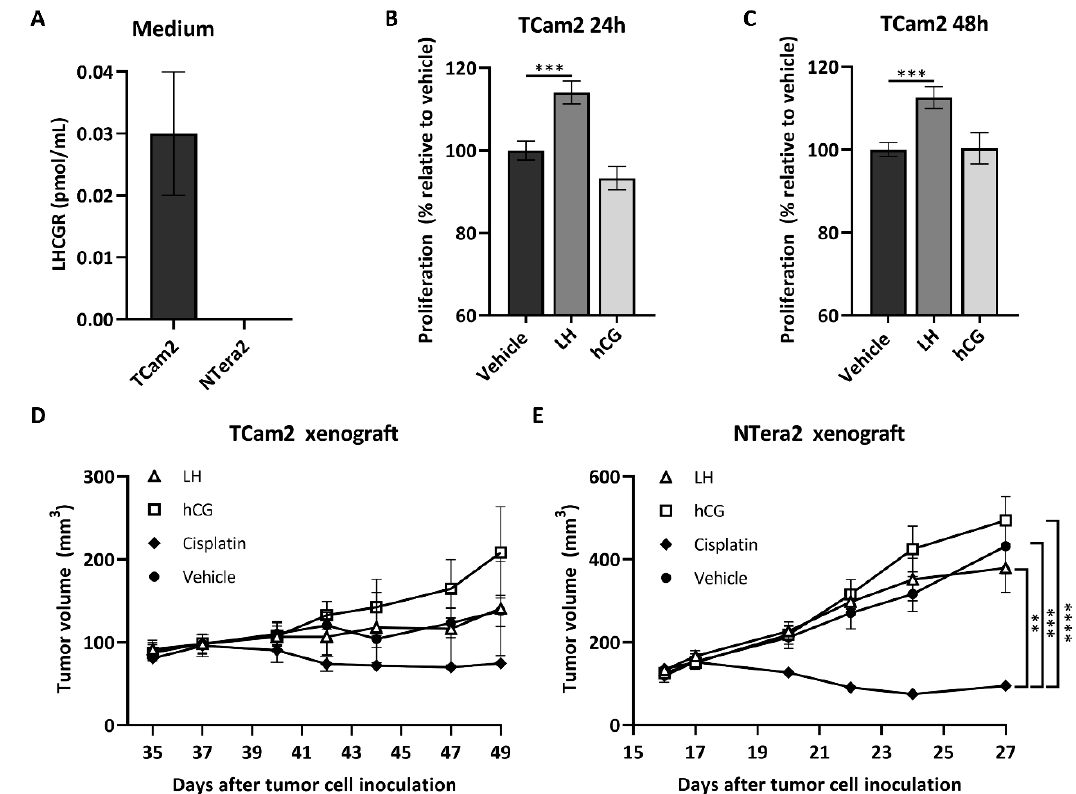
Figure 2. Stimulation of LHCGR increases proliferation of a seminoma-derived cell line. ( A ) LHCGR in cell culture medium from TCam2 and NTera2 cells measured by ELISA. TCam2 and NTera2 cells were grown until 85% confluency, the medium was changed, and the cells were cultured for 2–4 h before medium was harvested for analysis. Values represent mean ± SEM. The experiment was conducted in duplicates. ( B , C ) Cell proliferation of the seminoma-derived cell line TCam2 was analyzed by BrdU incorporation assay after 24 and 48 h of treatment with 1 IU/mL LH or hCG. Values represent mean ± SEM. All experiments are conducted in biological triplicates. *** p < 0.001 compared with vehicle treatment. ( D , E ) NTera2 or TCam2 cells were inoculated onto the flank of nude mice. At an average tumor volume of approximately 150 mm 3 , mice were randomized into different treatment groups and injected i.p. with LH (3 IU/kg 2 times/week), hCG (1000 IU/kg 3 times/week), cisplatin (6 mg/kg once), or vehicle (PBS) for 14 days. Tumor volume was measured 3 times/week and body weight determined once a week from the time of inoculation until termination. Values represent mean ± SEM for n = 10 ( D ) and n = 9 ( E ). ** p < 0.01, *** p < 0.001, and **** p < 0.0001. Abbreviations: hCG, human chorionic gonadotropin; LH, hormone/choriogonadotropin receptor.